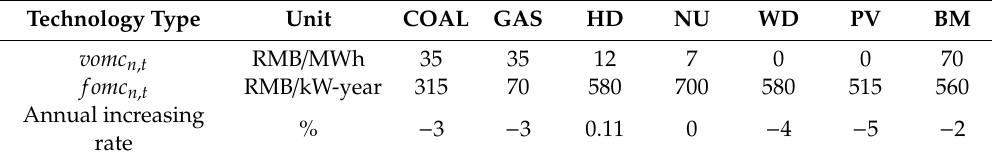
Table 9. Operation-and-Maintenance costs for the power technologies over the planning horizon.